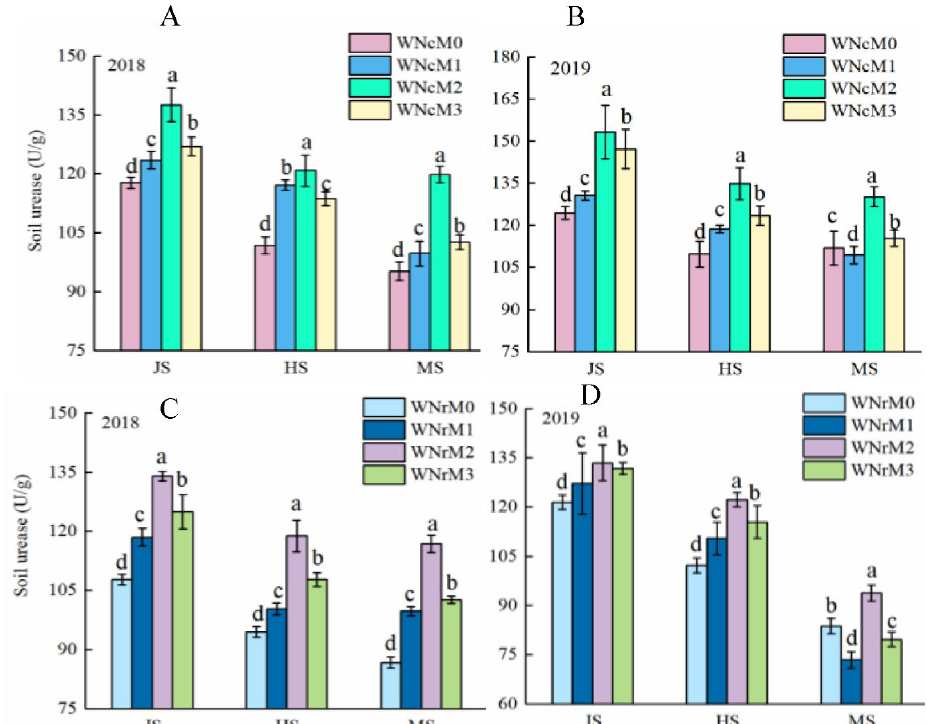
Figure 2. Effects of N application rate in the wheat season and N management in the rice season on paddy soil urease. JS: jointing stage; HS: heading stage; MS: maturity stage; ( A ) and ( B ) represent the conventional nitrogen application (WNc) in two years in the wheat season, ( C ) and ( D ) represent the reduced nitrogen application (WNr) in two years in the wheat season. M0 represents zero N was used in the rice season; M1, M2, and M3 represent the use of an application rate of 150 kg/hm 2 N in the rice season, and three N management models were applied, in which the application ratio of base:tiller:panicle fertilizer was 20%:20%:60%, 30%:30%:40%, and 40%:40%:20%, respectively. Lower-case letters indicate that the soil urease levels were significantly different among the treatments ( p < 0.05, LSD method).